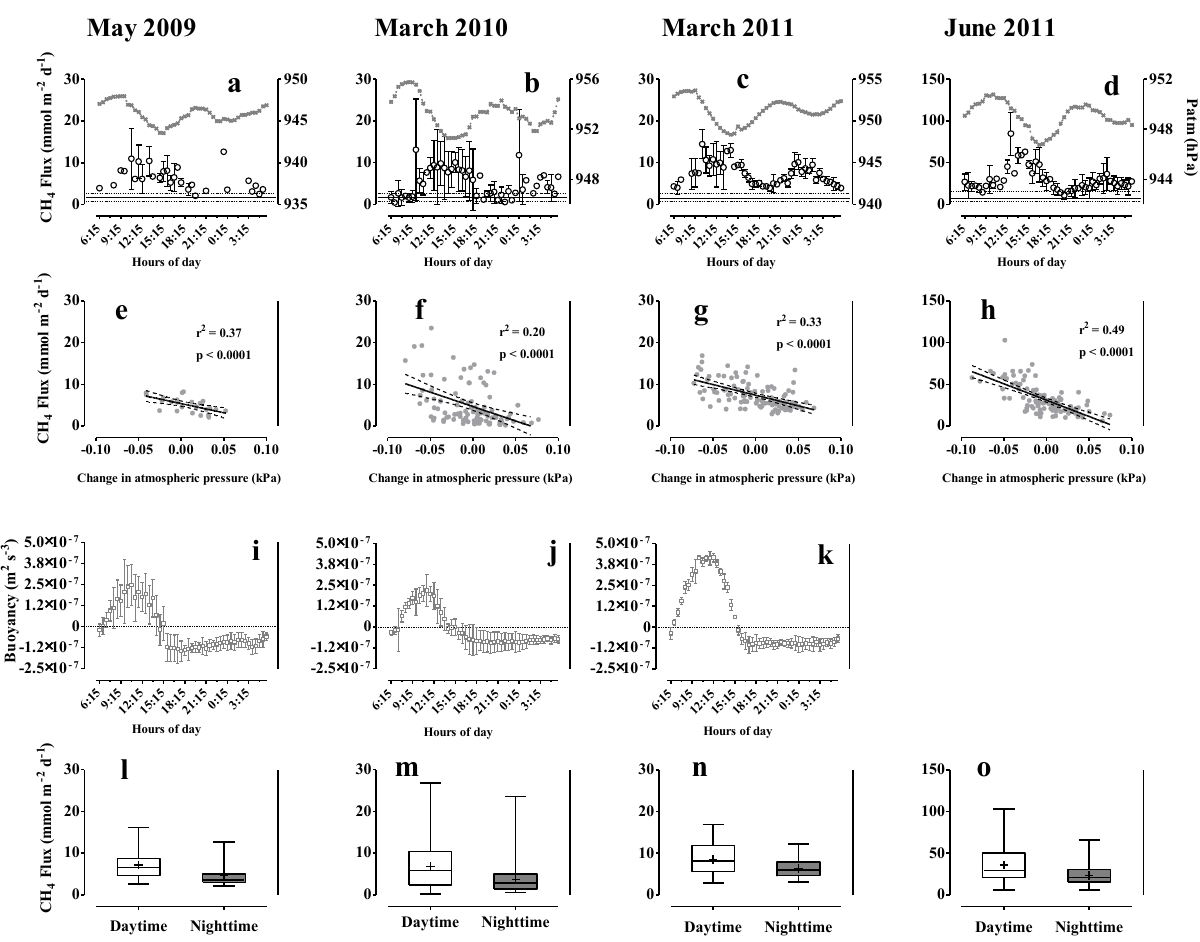
Figure 5. (a, b, c, d) : 30mn-binned CH 4 emissions measured by eddy covariance (DE EC ) (circle) and 30mn-binned atmospheric pressure (cross) for the four field campaigns. (e, f, g) : 30mn-binned buoyancy flux (note that the June 2011 data are not available). (h, i, j, k) : Individual 30min CH 4 emissions measured by eddy covariance (DE EC ) versus change in the atmospheric pressure for the four field campaigns. (l, m, n, o) : Nighttime and daytime range for CH 4 emissions measured by eddy covariance (DE EC ) for the four field campaigns. Note that the y axis scale differs for the June 2011 campaign (d, k, o) . In panels e–h , the solid line is the regression line and the dash lines represent the confidence